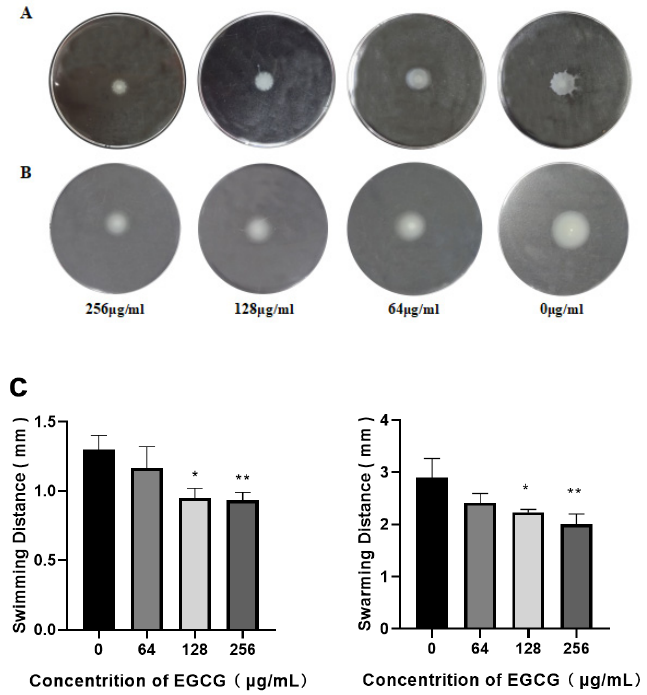
Figure 7. Motility abilities of P. aeruginosa on special agar plates. ( A ). Swimming, ( B ). Swarming, ( C ). The diameter of movement distance of P. aeruginosa . (All data are representative of three independent experiments performed in triplicate and expressed as the mean ± SD values in each bar. * p < 0.05; ** p < 0.01.